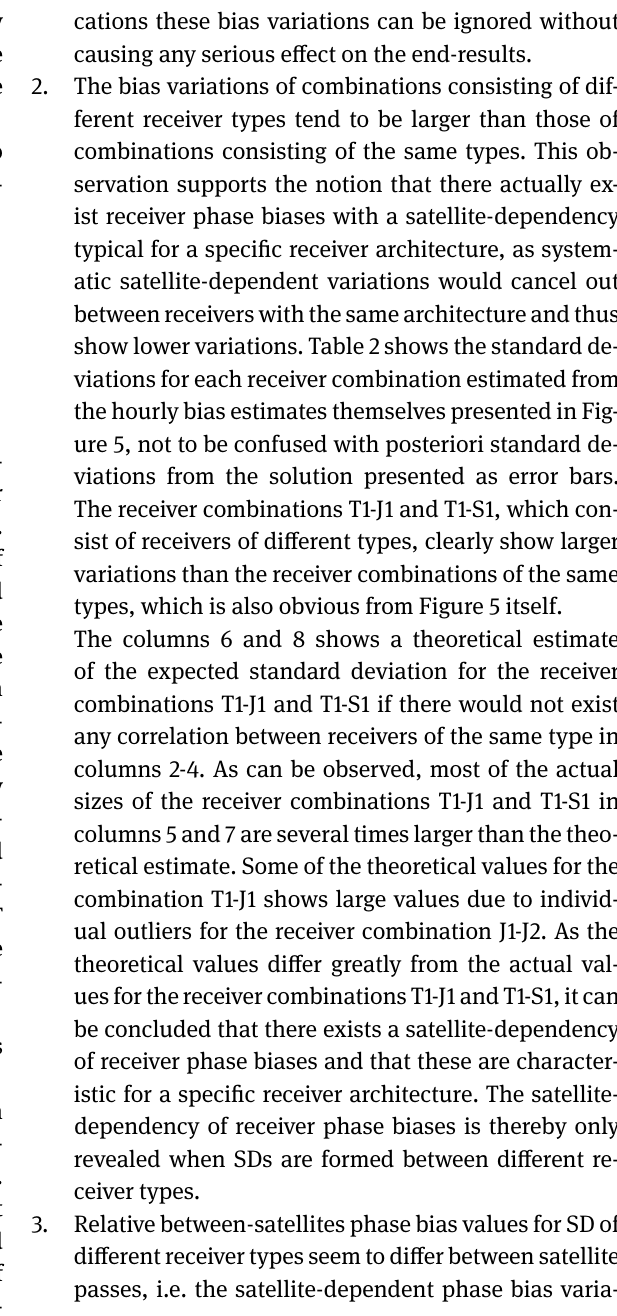
Figure 5: Hourly phase biases of various receiver combinations at DOY 2